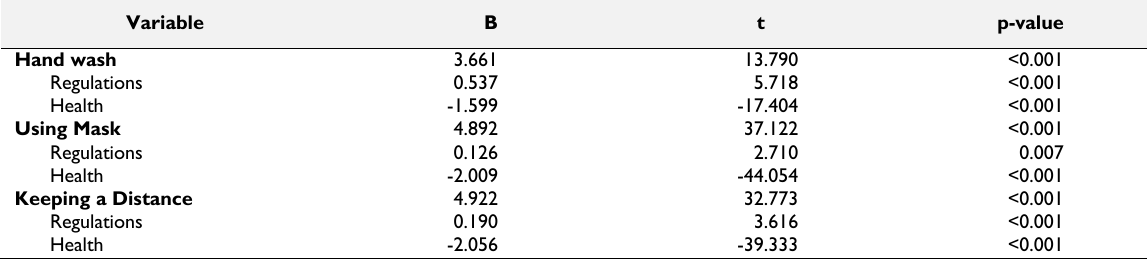
Table 5 Test results analysis of reasons for the habit of using masks, washing hands and keeping a distance